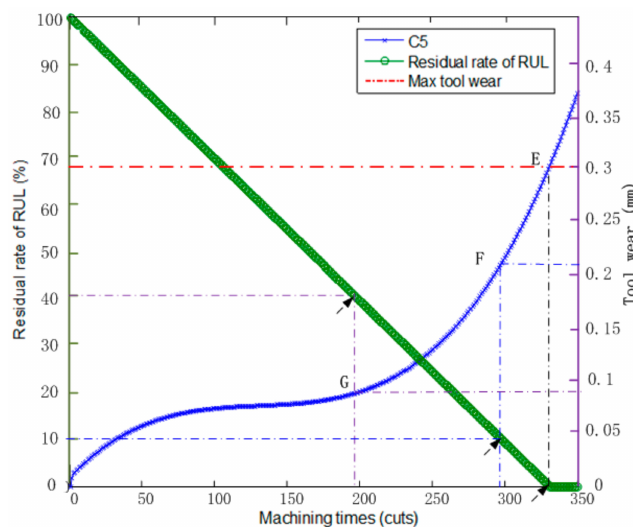
Figure 16. The result of the online RUL prediction.